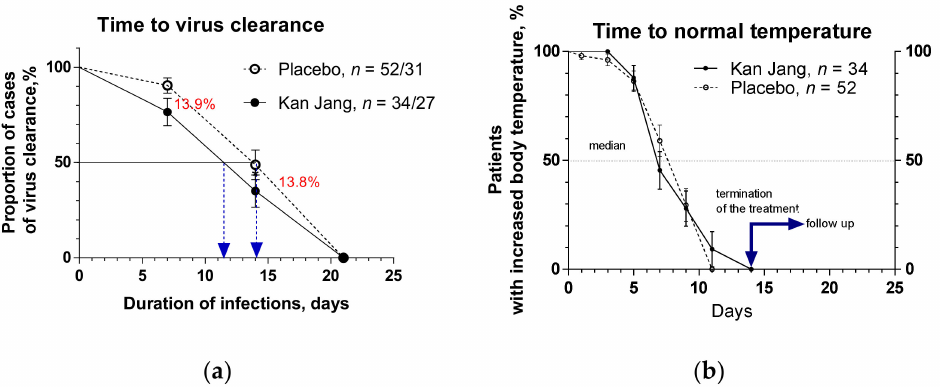
Figure 3. ( a ) The virus clearance in the treatment and control groups: Kaplan–Meier curves show the percent of patients with SARS-CoV-2 virus over the time from randomization (Day 1) to the end of the treatment (Day 14) and the follow-up period for one week (Day 21) in the treatment and control groups; hazard ratio Kan Jang/placebo = 1.891, 95% CI of ratio from 0.5969 to 1.675. ( b ) Duration of increased body temperature (from >37 ◦ C to <38 ◦ C) in the treatment and control groups; median recovery: Kan Jang ® —7 days, placebo—9 days; hazard ratio Kan Jang/placebo = 1.125, 95% CI of ratio from 0.5778 to